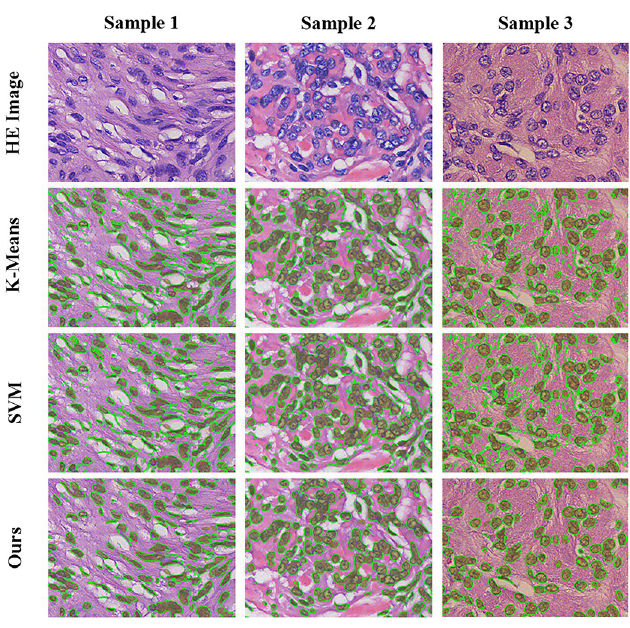
Fig 6. Comparison of the segmentation results with those of traditional machine learning methods. Each row represents the segmentation results of different methods, and each column represents different samples. The olive areas in the image represent ground truth, and the green line represents the result of nuclear segmentation using the corresponding method.